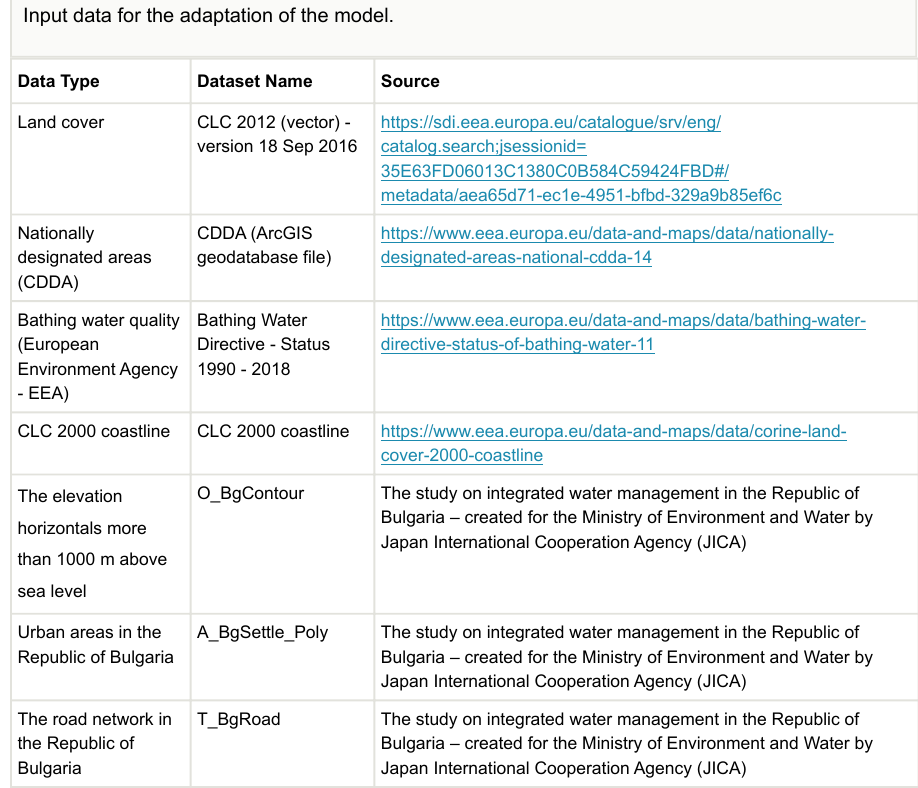
Mapping the natural heritage as a source of recreation services at national